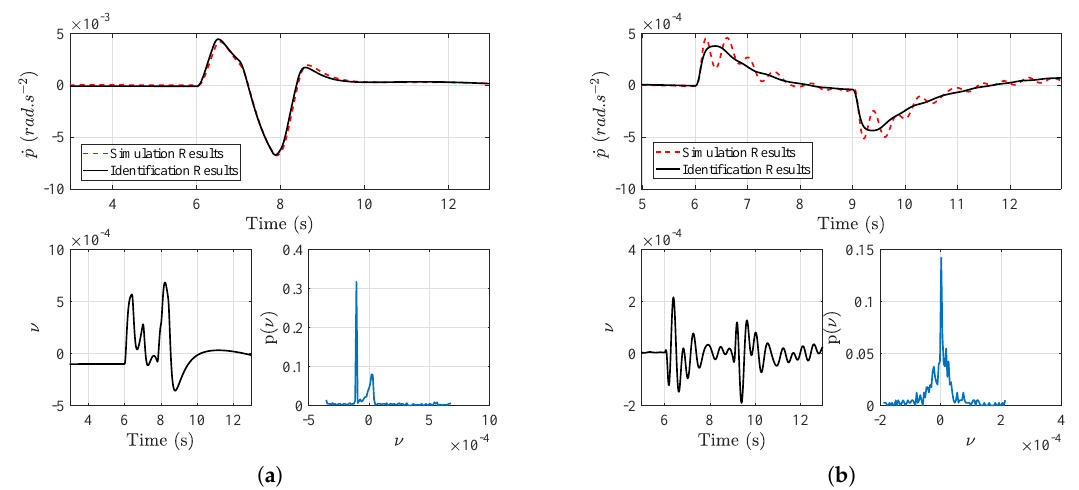
Figure 9. SID match for ˙ p of the AX-1 with 20% wingtip (aileron step input, TAS = 200 m · s − 1 and h = 4575 m): ( a ) Γ wt = 30 ◦ rigid; and ( b ) Γ wt = 30 ◦